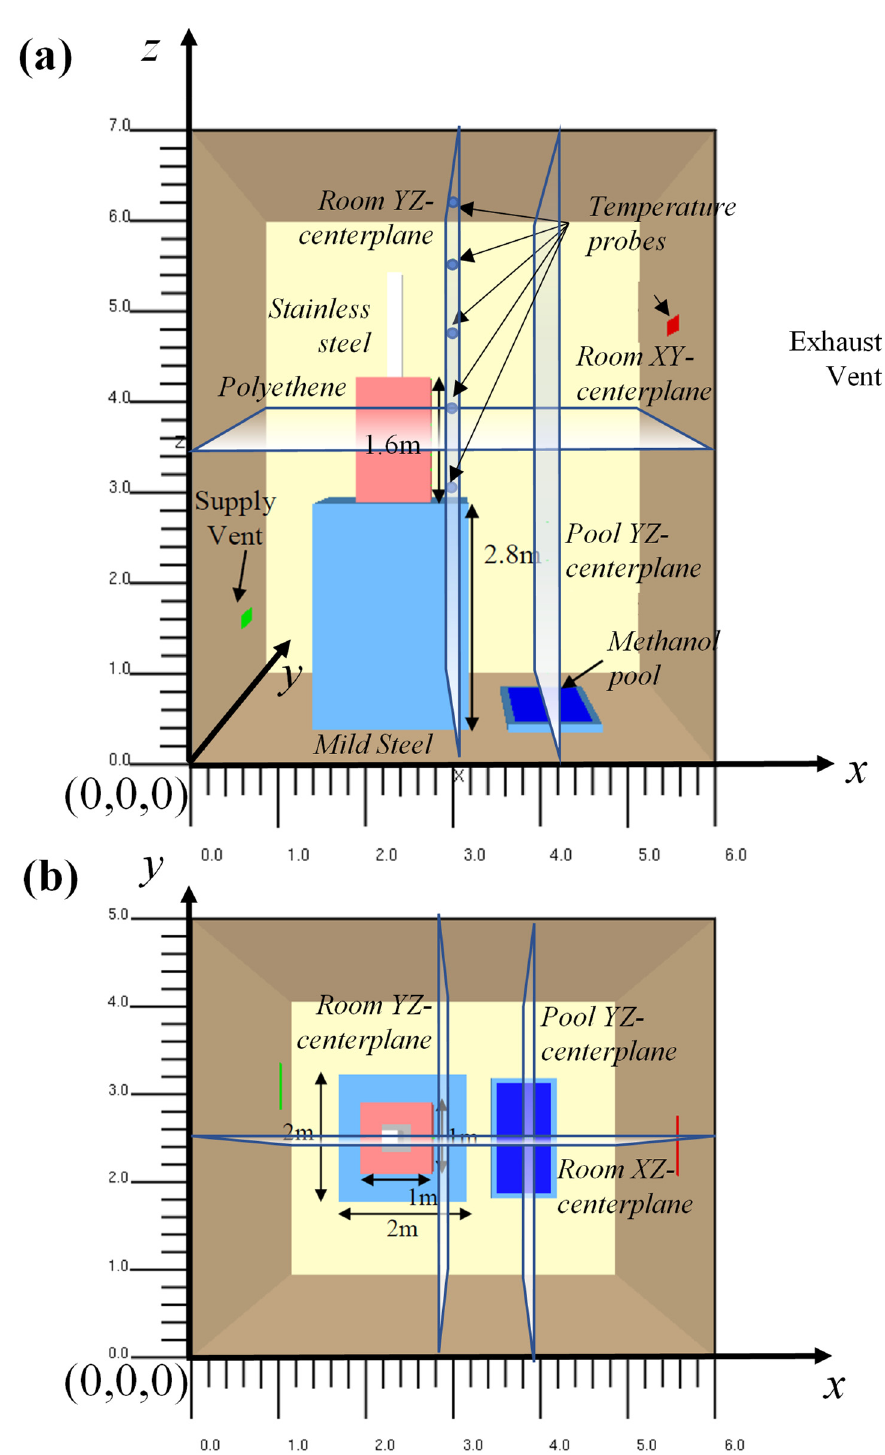
Figure 1. The schematic diagram for the methanol cleaning system inside an enclosure ( a ) front view and ( b ) top view of the cleaning room. The system consists of a methanol pool, an exhaust and supply vent system, and a polyethylene shield (in pink